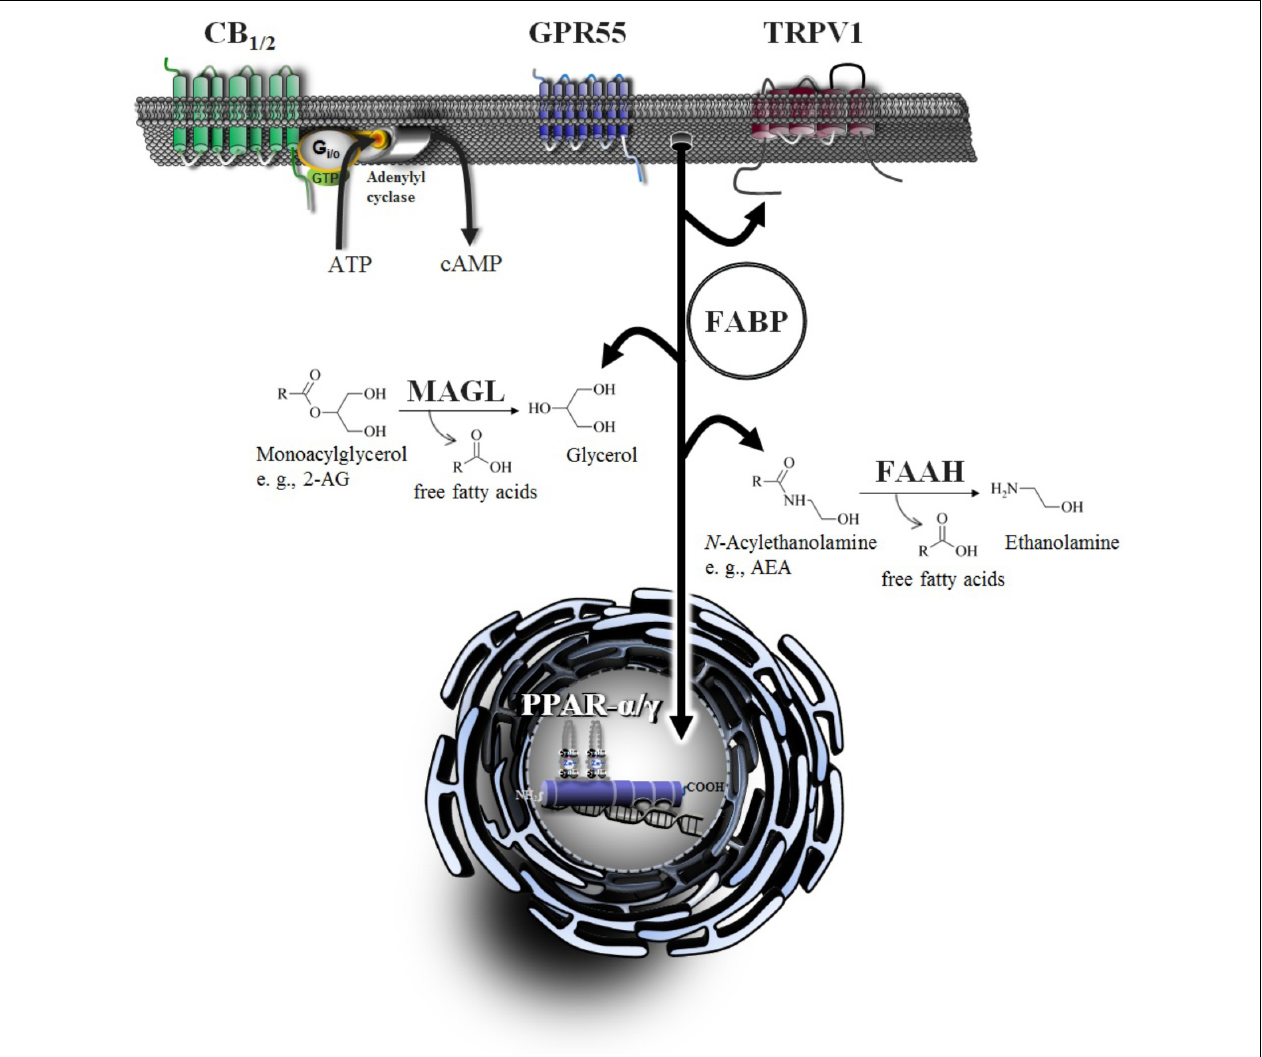
FIGURE 1 | Signaling and degradation of endocannabinoid compounds within the extended endocannabinoid system. CB 1 and CB 2 , cannabinoid receptors type-1 and -2; FAAH, fatty acid amide hydrolase; FABP, fatty acid binding protein; GPR55, G protein-coupled receptor 55; MAGL, monoacylglycerol lipase; PPAR, peroxisome proliferator-activated receptor; TRPV, transient receptor potential vanilloid